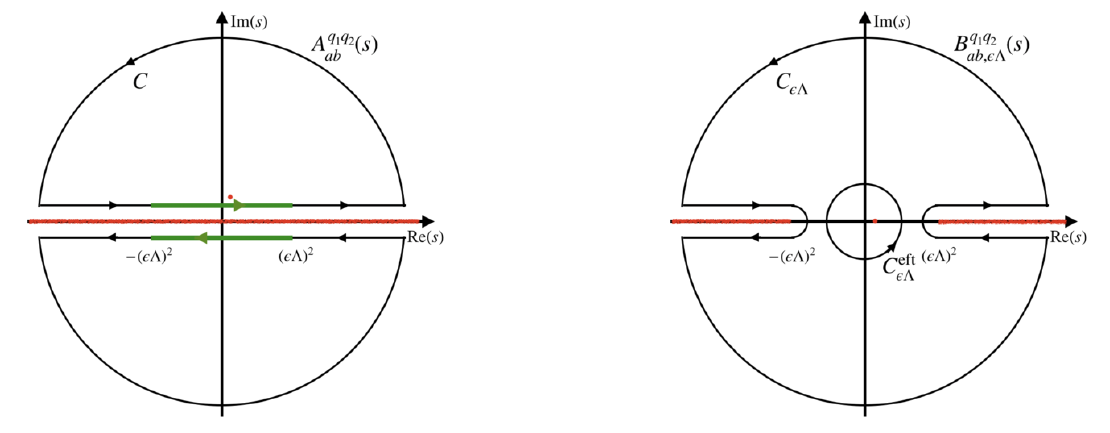
Figure 2 . Dispersion relation contours in the forward